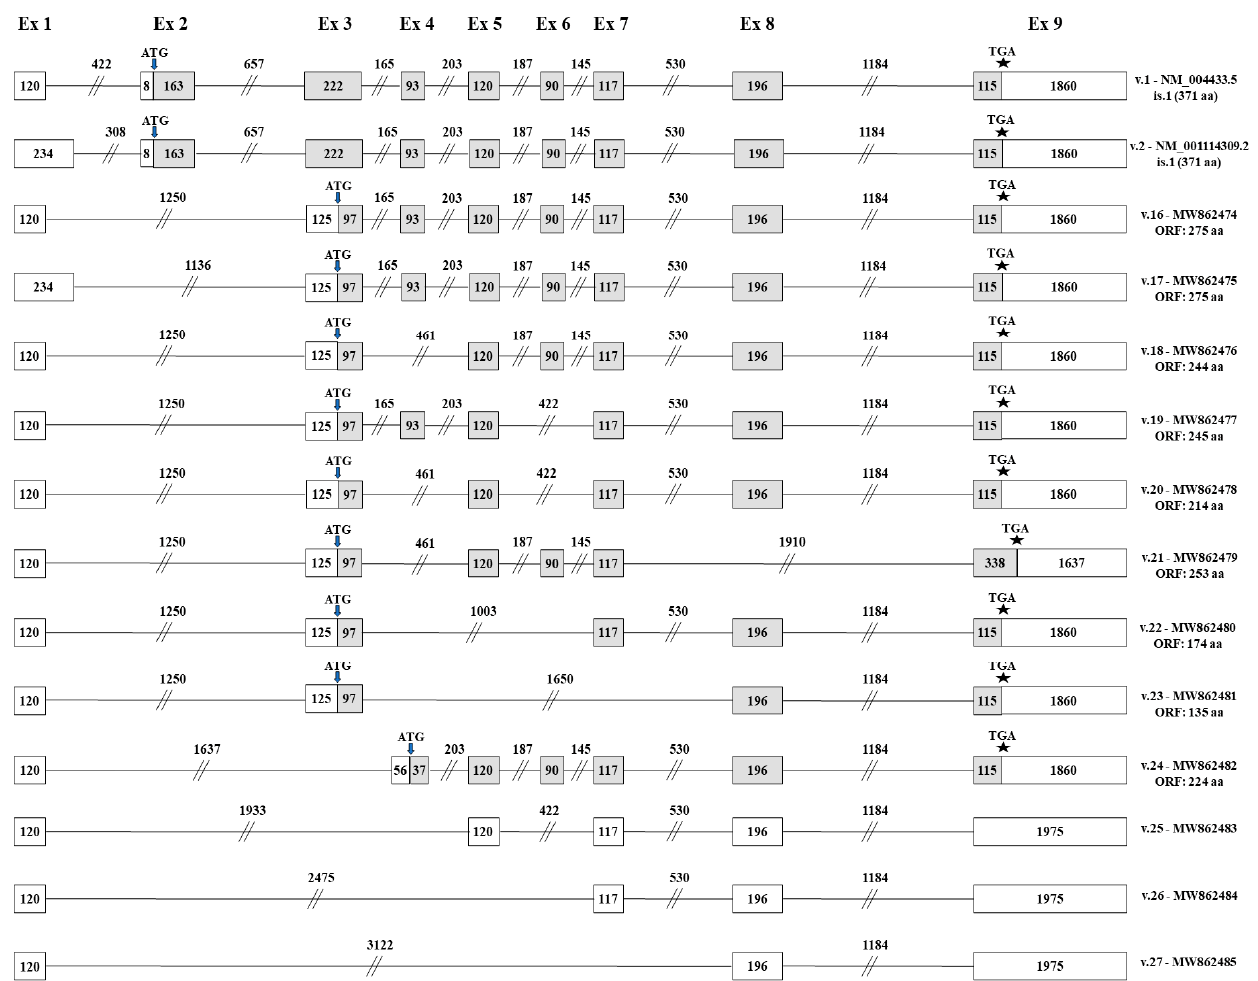
Figure 4. Detailed structure of the novel ELF3 transcript variants bearing alternative translation initiation codons. Exons are shown as boxes and introns as lines, while the numbers that characterize every box and line indicate their length in nucleotides. Gray and white boxes represent coding and non-coding exons, respectively. The positions of the ATG and TGA codons are pointed out with arrows ( ↓ ) and asterisks (*), accordingly.